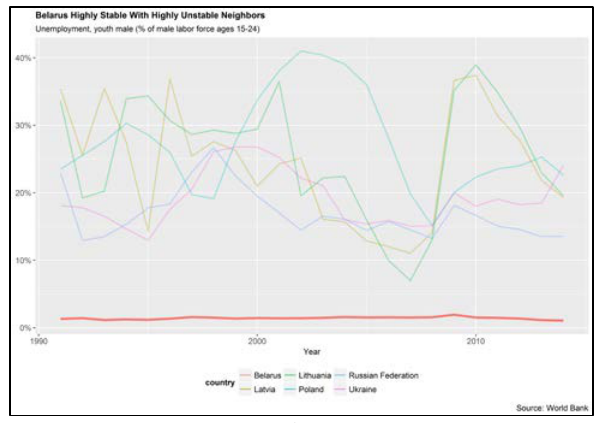
Figure 6. Belarus Identified with the Lowest unemployment in Belarus remained incredulously low and stable, ranging from a minimum of 1.06% in 2014 and a maximum of 1.9% in 2009. During the same period, the neighbour of Belarus saw multiple double digits swings from year to year. On the opposite side, countries that are much more unstable through time than their neighbours, one country dwarfs the rest. South Korea’s only neighbour (by our queen contiguity definition) is North Korea and North Korea’s reported youth male unemployment trend is remarkably stable, bouncing between 12.5-12.7% from 1996-2014. Figure 7 shows these trends Figure 4. Comparison of a Country’s ASI ( ) to the Average of its Neighbours 𝛼𝛼 Looking at the spatial distribution of our spatially weighted ASI values, 𝜶𝜶 𝒔𝒔𝒔𝒔